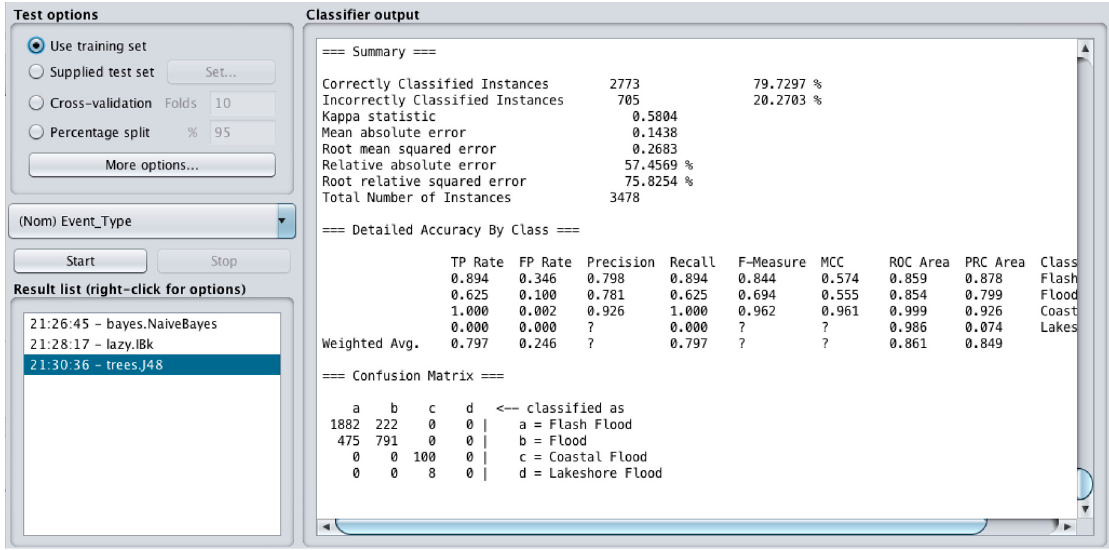
Figure 9. Evaluation Results for J48 model in Weka.